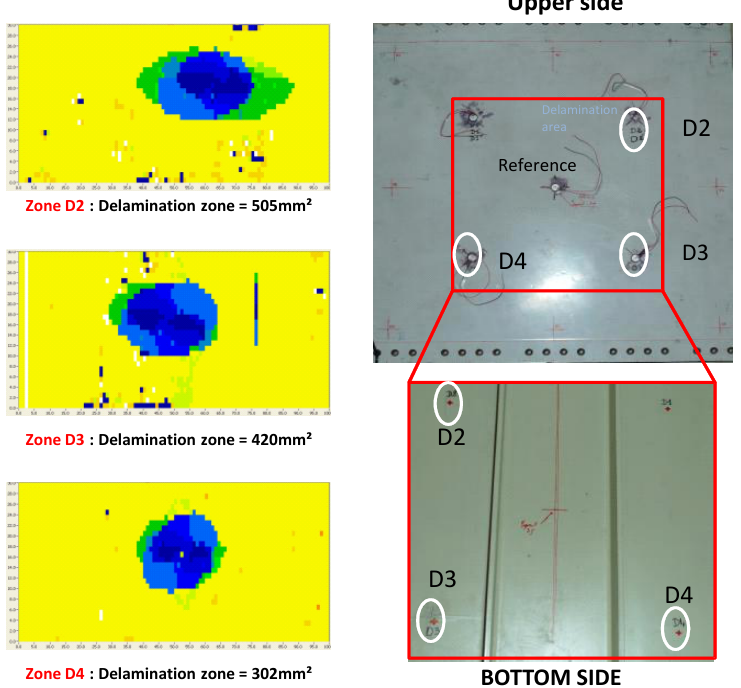
Figure 8. C-scan of the introduced delaminations, D2 area = 505 mm², D3 = 420 mm², D4 = 302 mm² and photos of the upper and bottom face of the structure with mounted sensors.